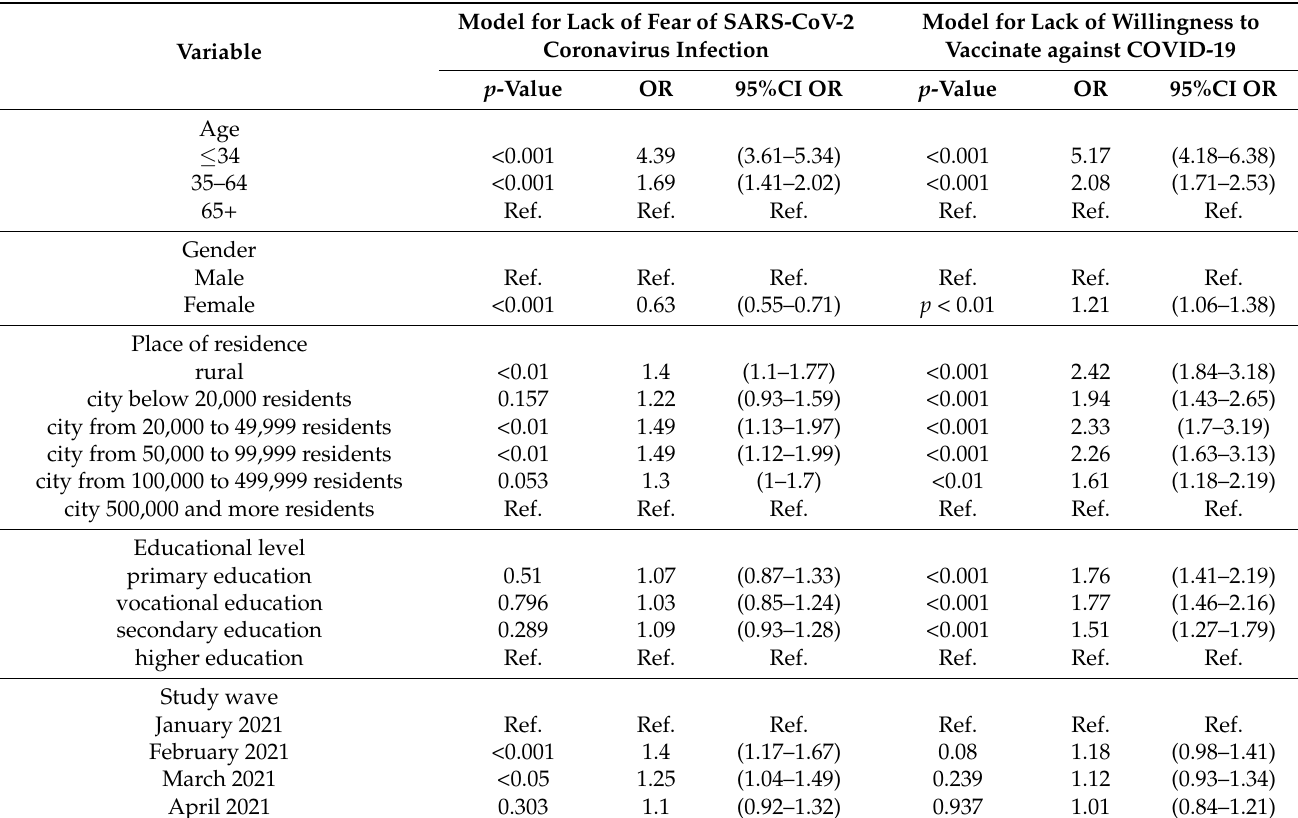
Table 4. Associations between lack of fear of SARS-CoV-2 coronavirus infection and negative attitudes towards the COVID-19 vaccination—multivariable logistic regression